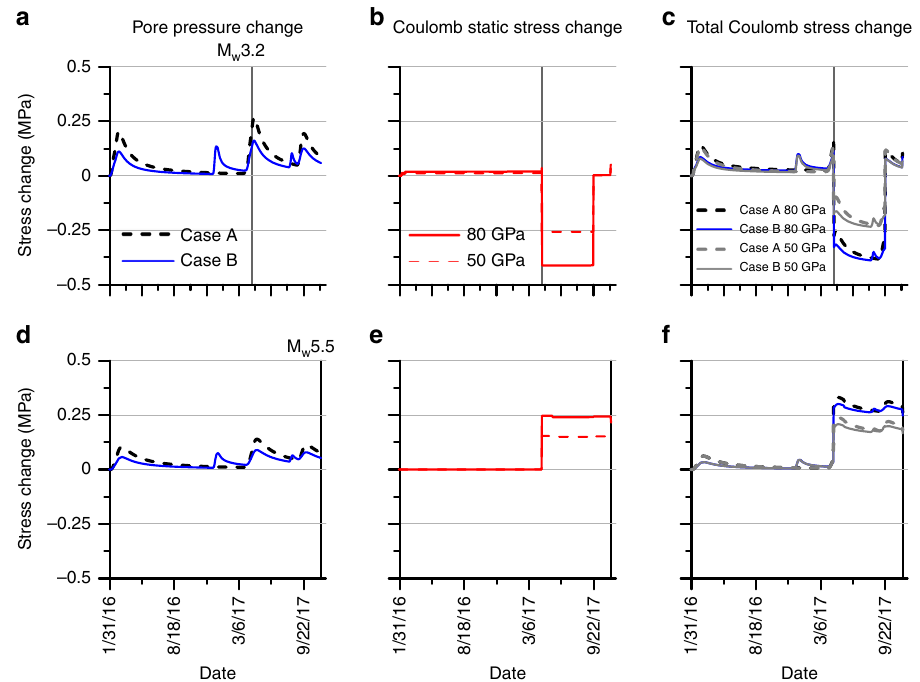
Fig. 6 Pore pressure and Coulomb static stress transfer modeling. The model results are for the M w 3.2 foreshock location (top row, a – c ) and the M w 5.5 mainshock location (bottom row, d – f ). Pore pressure modeling results ( a , d ) for Case A (black dashed) and Case B (blue). Coulomb static stress transfer modeling results ( b , e ) at each location using a Young ’ s modulus of 80 GPa (red) and 50 GPa (red dashed). Total Coulomb stress change ( c , f ) is calculated by adding modeled pore pressures multiplied by a coef fi cient of friction of 0.6 and the Coulomb static stress change. Results for modeling using a Young ’ s modulus of 80 GPa is in blue and dashed black; modeling using a Young ’ s modulus of 50 GPa is in gray. The M w 3.2 event is marked in the fi rst row by a vertical gray solid line and the M w 5.5 event is marked in the second row by a vertical black line. Source data are provided as a Source Data fi